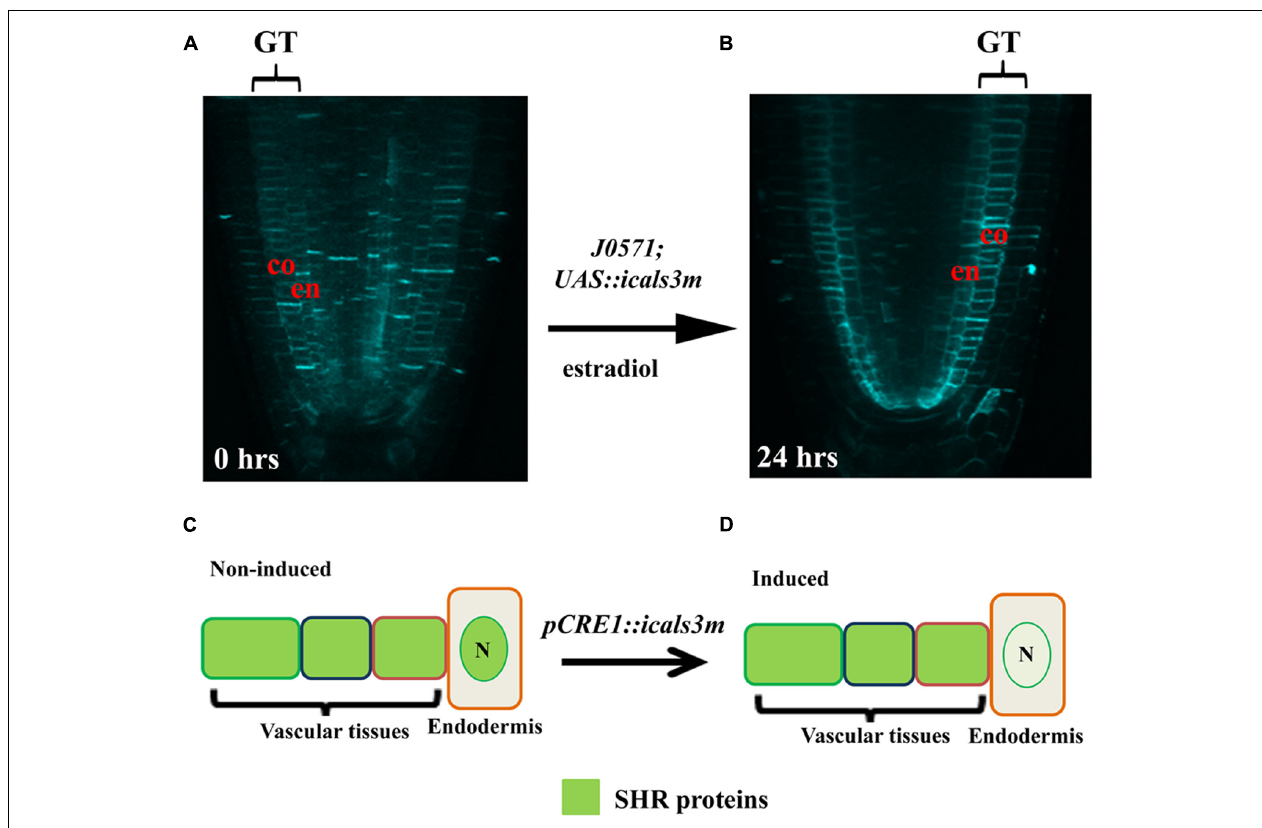
movement. (C) In non-induced condition, the SHR protein (green signal) is distributed in the cytoplasm of vascular tissues but after moving to the endodermis, the protein gets localize to the nucleus (N). (D) When cals3m is induced in the vascular tissues using CRE1 promoter, it blocks the movement of SHR protein from vascular tissues to the endodermis, suggesting that SHR protein move through PD (Vatén etal.,